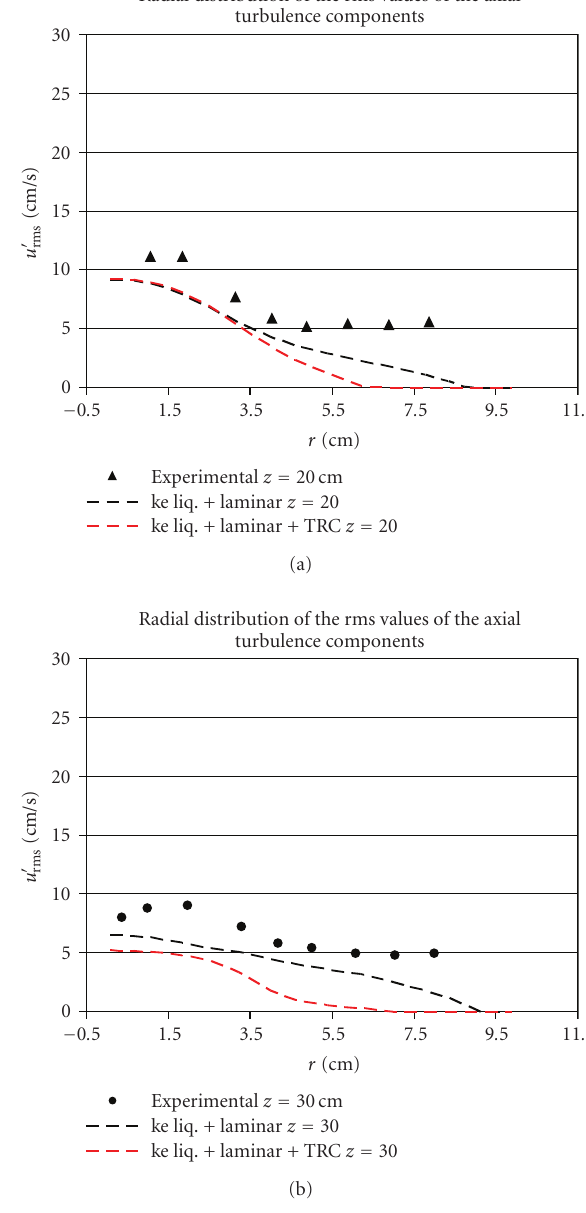
Figure 3: Radial distribution of the root-mean-square values of turbulence components.